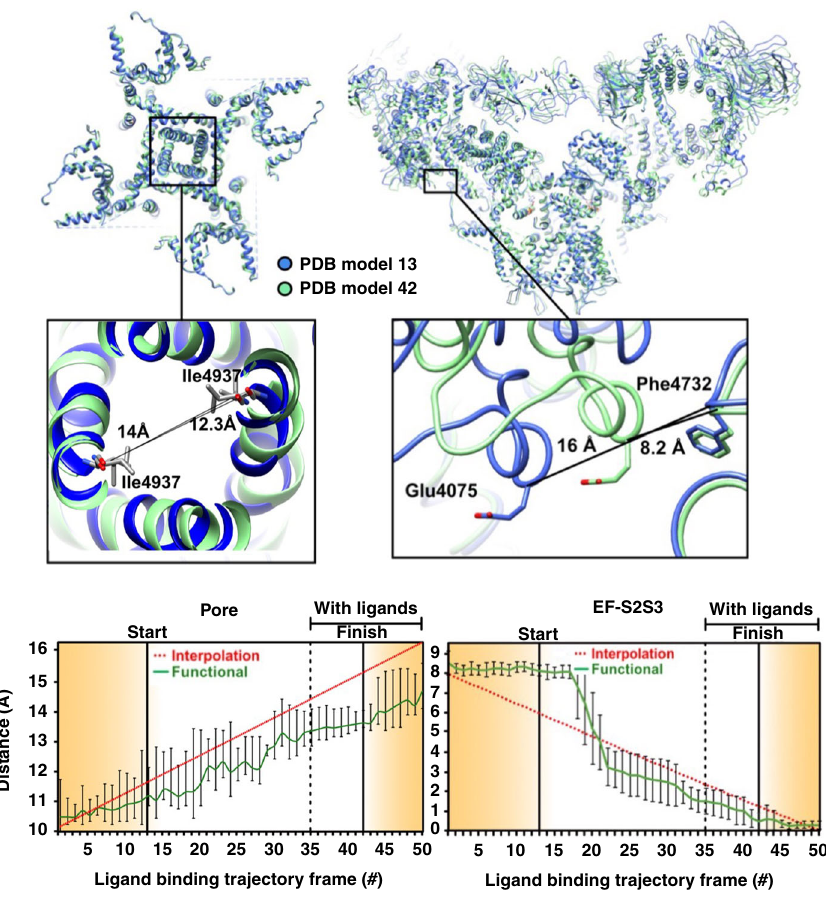
Fig. 4 Conformational changes in the pore and EF-hand domains along the augmented functional path. The general region and the speci fi c sites (insets) are examined in detail. Distance variations between two amino acid backbones: in the pore measured at Ile4937 (left); and between EF hand (EF) at Glu4075 and S2S3 domain at Phe4732 (right). The amino acids used for measurement are represented as sticks, the rest of the molecule in blue ribbon for the model corresponding to “ START ” in Fig. 1a, and in green ribbon for model corresponding to “ FINISH ” . Error bars represent the full scatter (not standard deviation) of the results obtained with six different starting